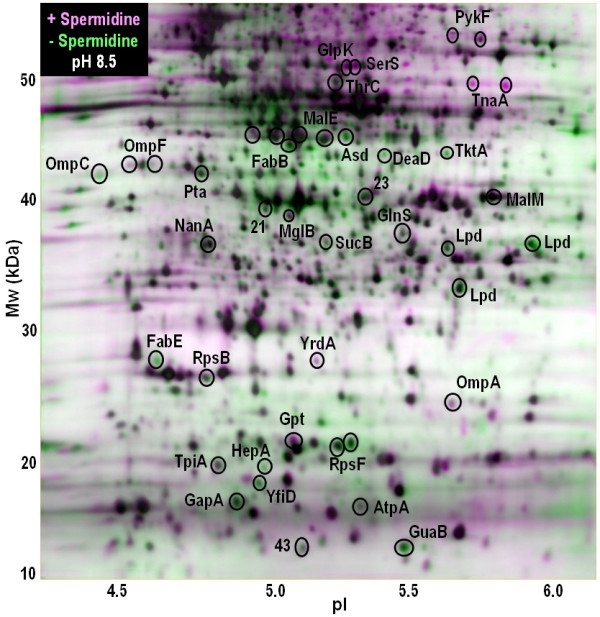
Protein profiles in the presence or absence of 10 mM spermidine. Cultures were grown as for Fig. 2B in LBK 100 mM TAPS, pH 8.5, with (pink) or without (green) 10 mM spermidine.